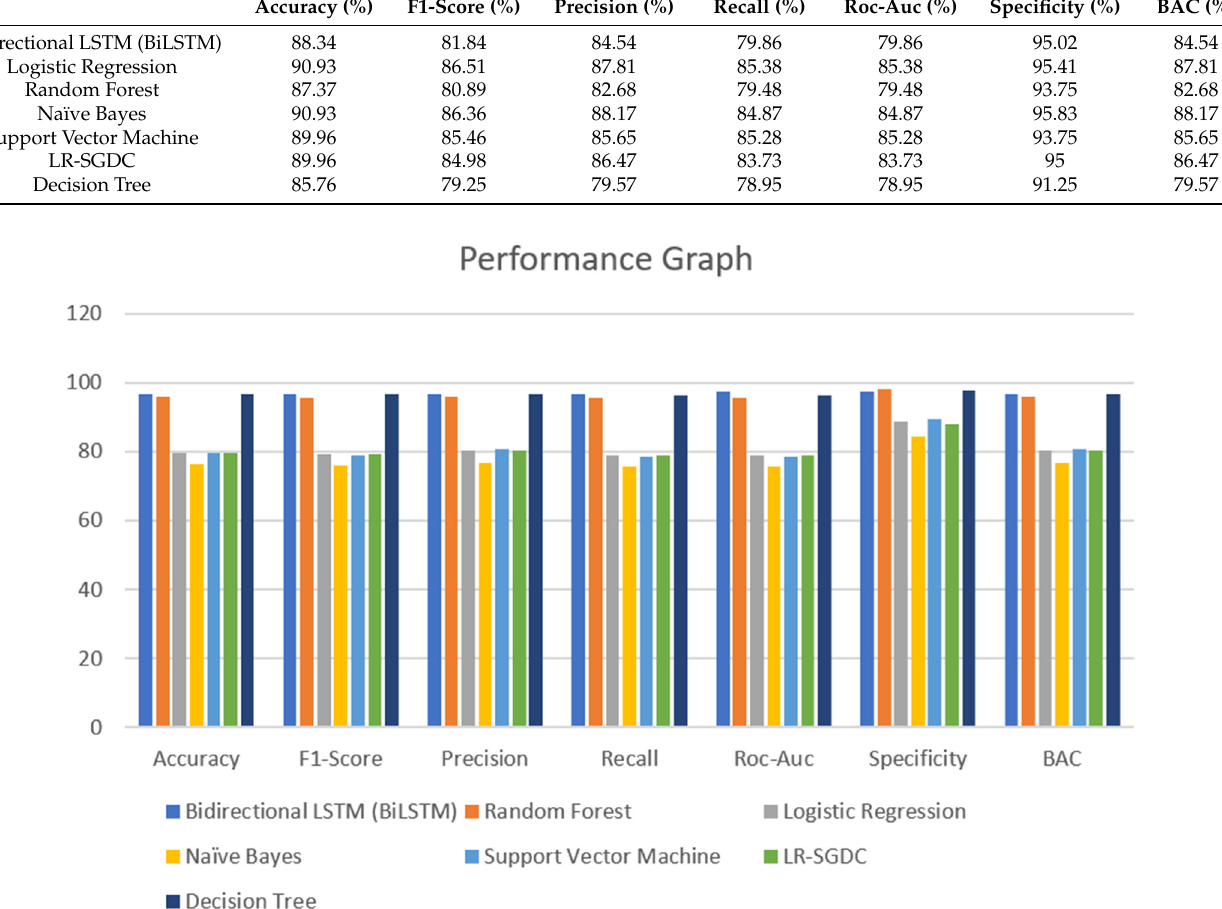
Figure 13. Performance graph of different classifiers for first dataset.